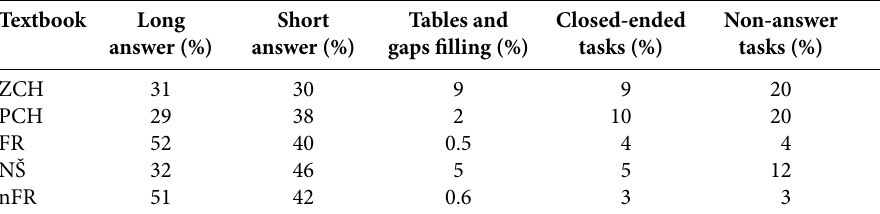
Table 5: Tasks in textbooks according to the type of response requested Textbook Long Short Tables